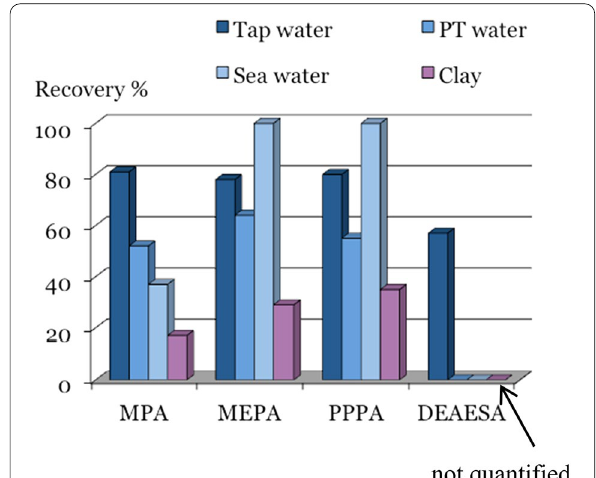
Fig. 4 Recovery (%) of APAs (10 μg/ml) and DEAESA in different water samples and in a clay extract. The solution was evaporated to dryness, and the residue was dissolved in AcMeOH before TMSDAM